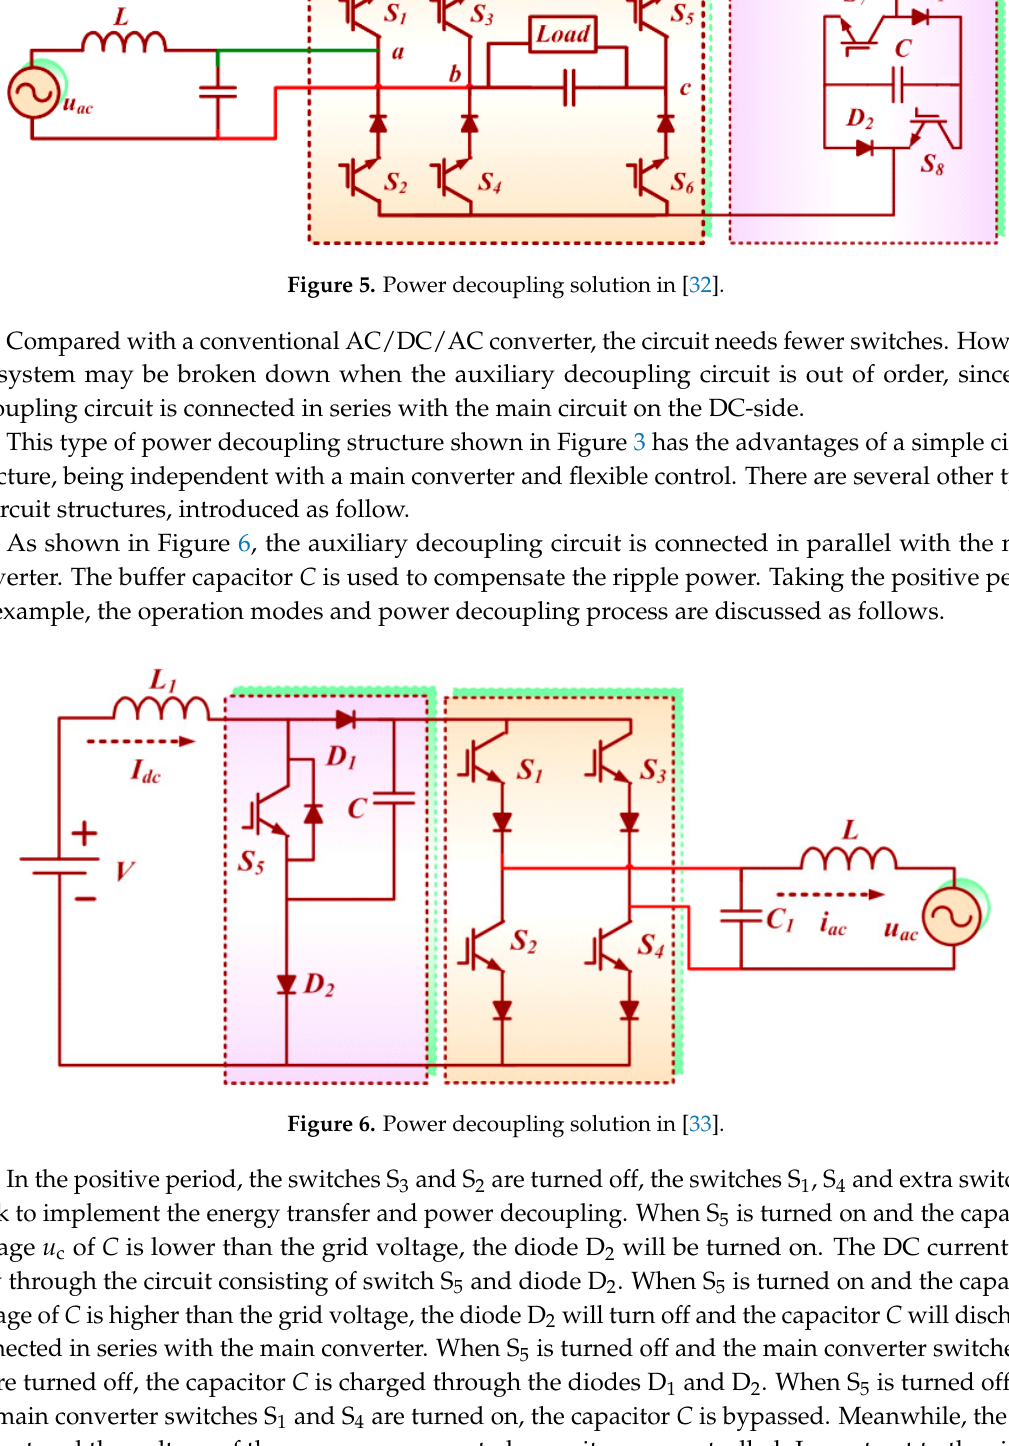
Figure 7. Power decoupling solution in [34].